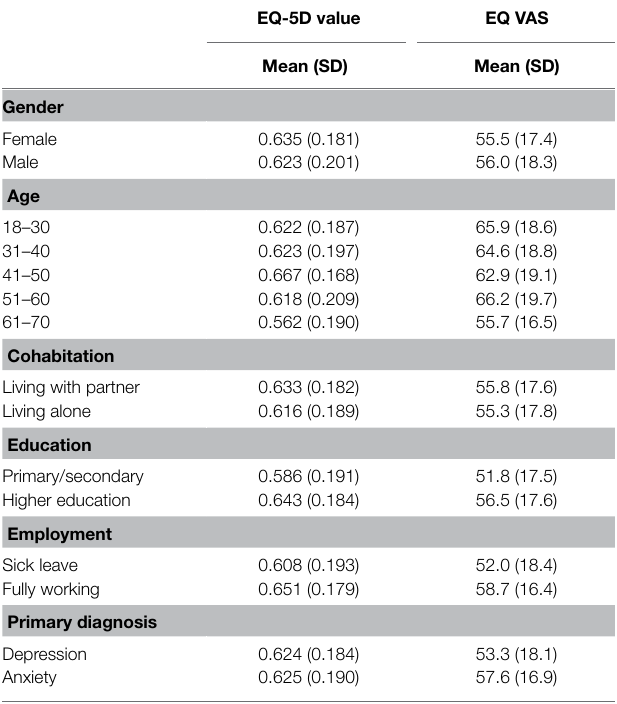
TABLE 3 | Mean EQ-5D value and EQ VAS by sociodemographic and clinical characteristics ( N =